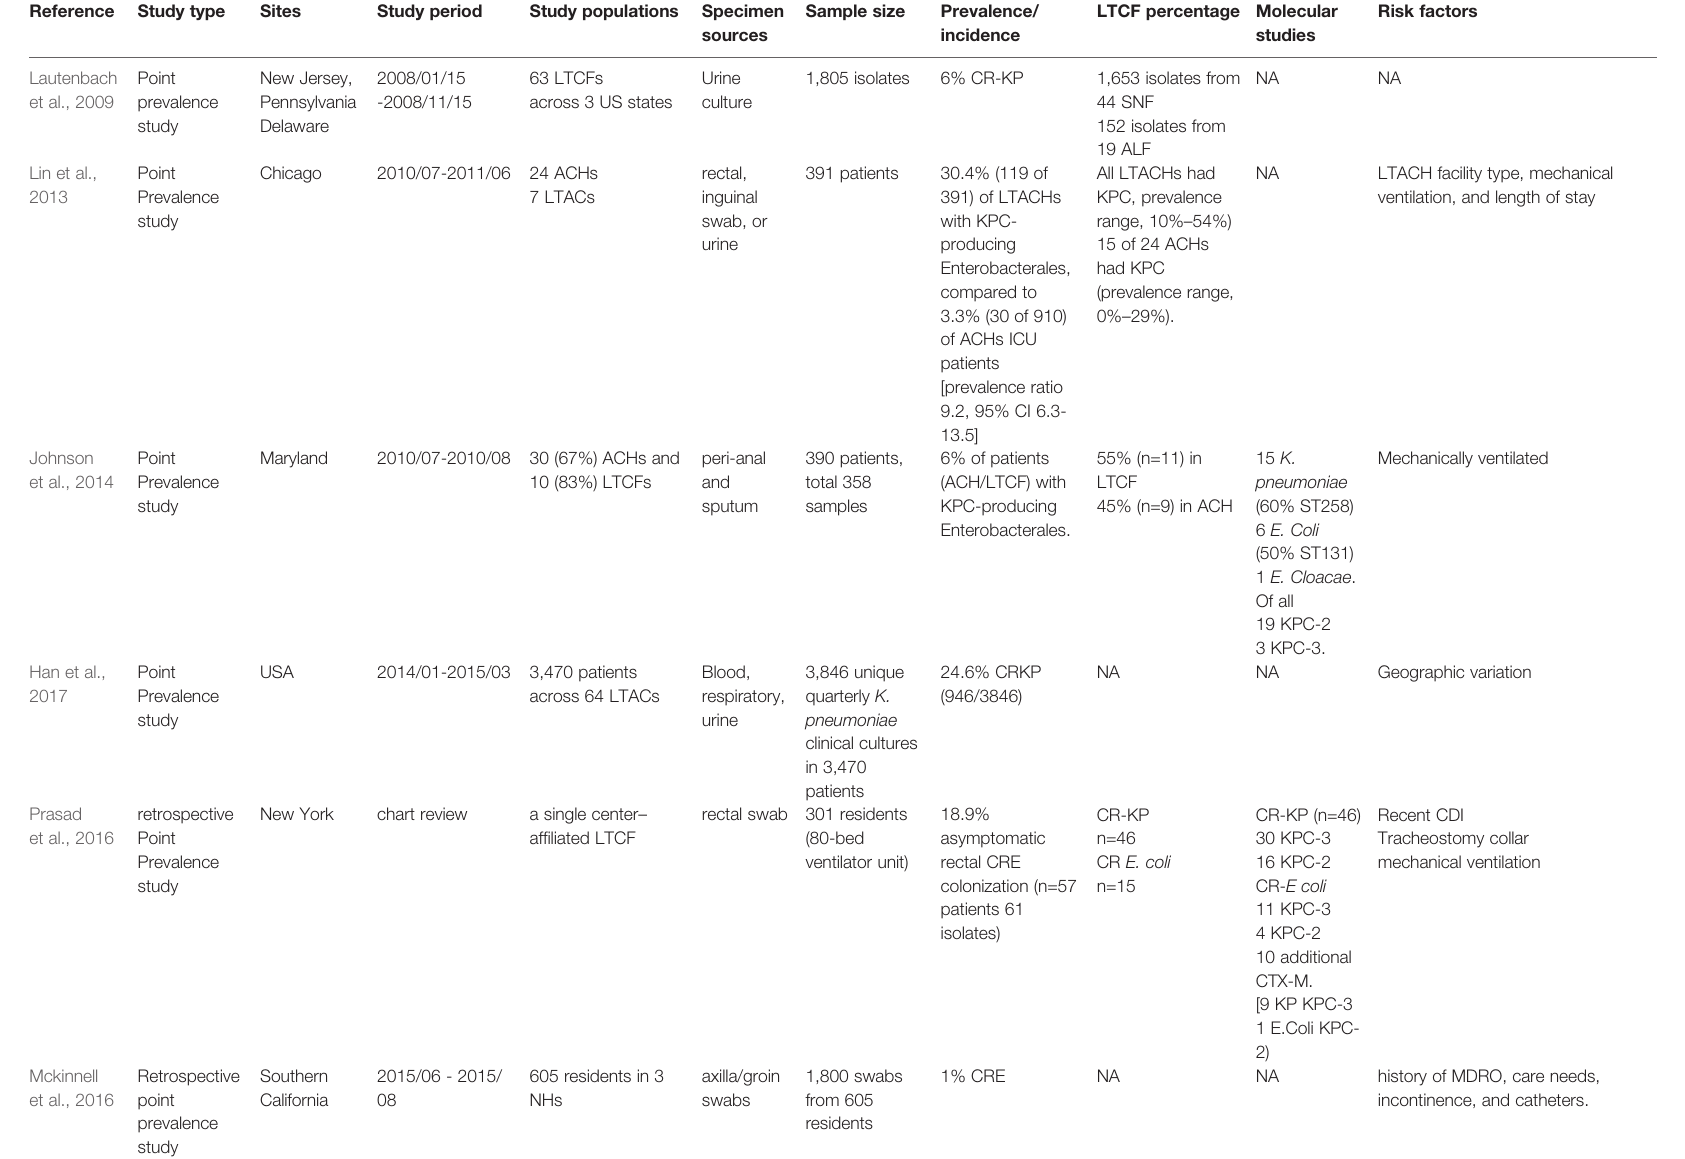
TABLE 1 | Studies of carbapenem-resistant Enterobacterales colonization in long-term care facilities in the United